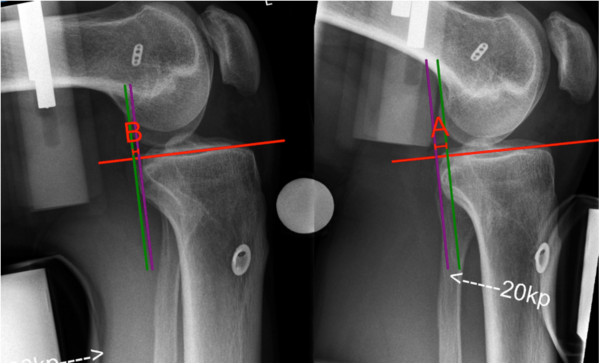
Posterior tibial displacement (A) and anterior tibial displacement (B) on stress radiograph with an applied load of 20 kp.